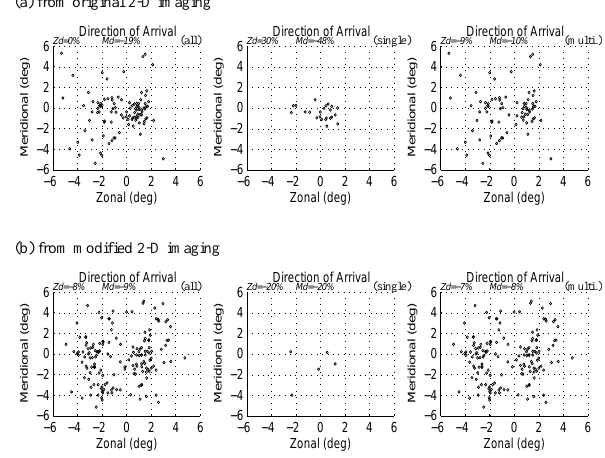
(b) from modified 2-D imaging